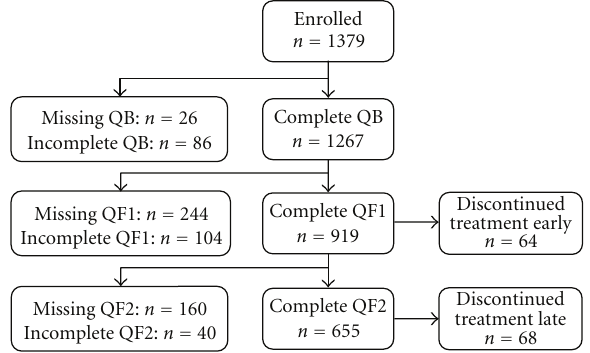
Figure 1: Patient flow